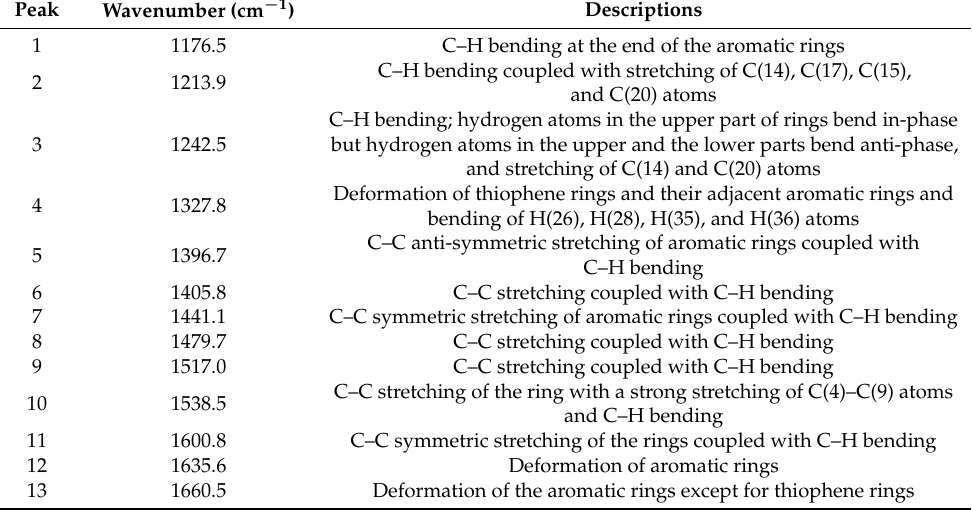
Table 1. Descriptions of the vibrations in the calculated vibrational